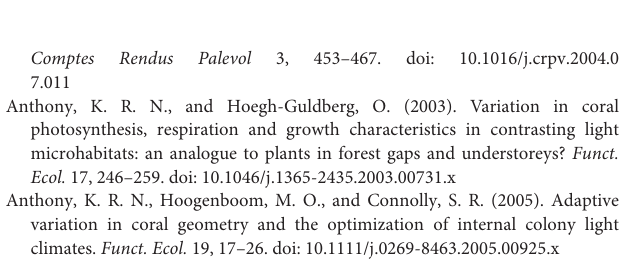
Figure S1 | Relationship between bleaching response and mean growth rate per growth form. Table S1 | Character states and sources for each coral species. Table S2 | Phylogenetically independent contrasts (PIC) analysis results. Table S3 | Metrics quantifying the efficacy of the corallite irradiance due to light transport from the coenosteum (see section on “ Differences in Skeletal Micro- µ s ′ of Corallites and Coenosteum Explain, in Part, Heterogeneous Light Environment Between Polyp and Coenosarc and are Associated With Bleaching Susceptibility ” for